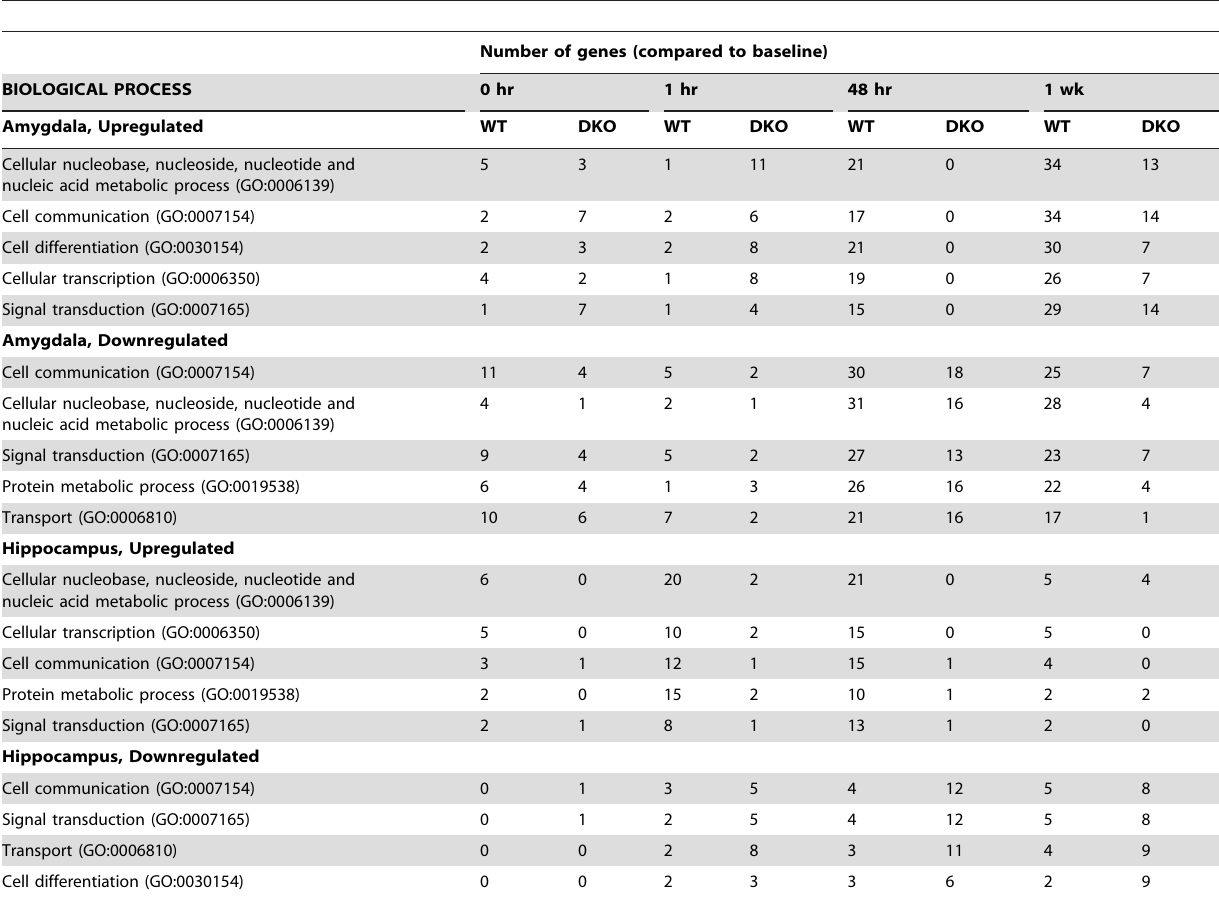
Table 2. Top 5 functions represented by each respective gene list.